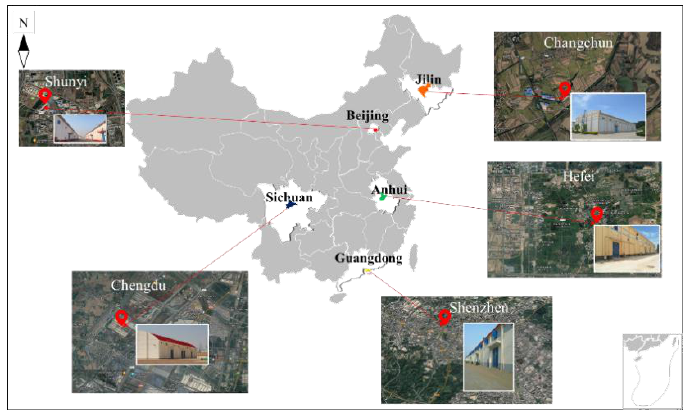
Figure 1. Location of sampling points. Table 1. Sample information.